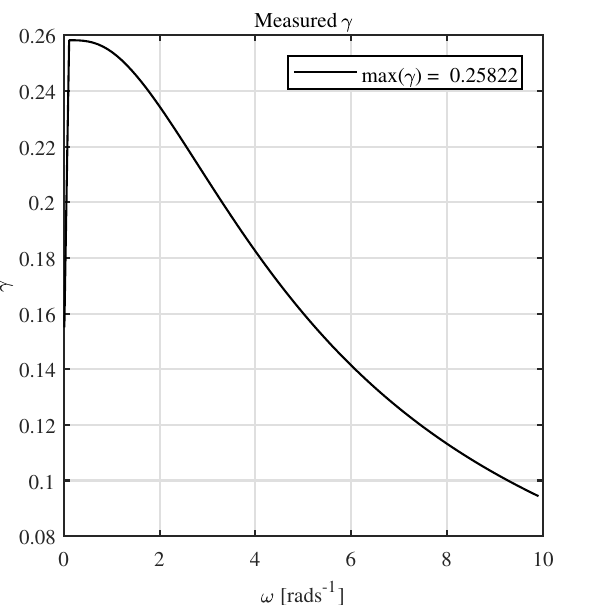
Figure 5: Measured γ according to ω